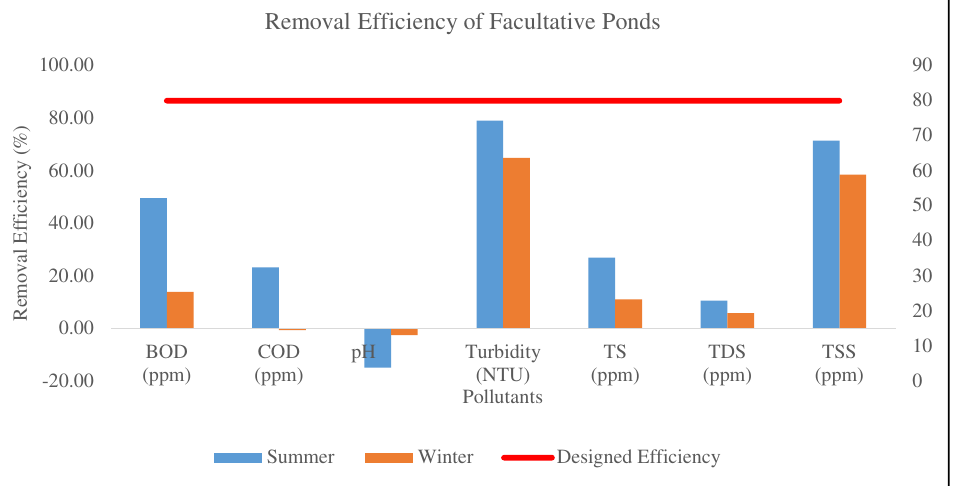
Fig. 3: Removal Efficiency of Facultative Ponds in Removing Selected